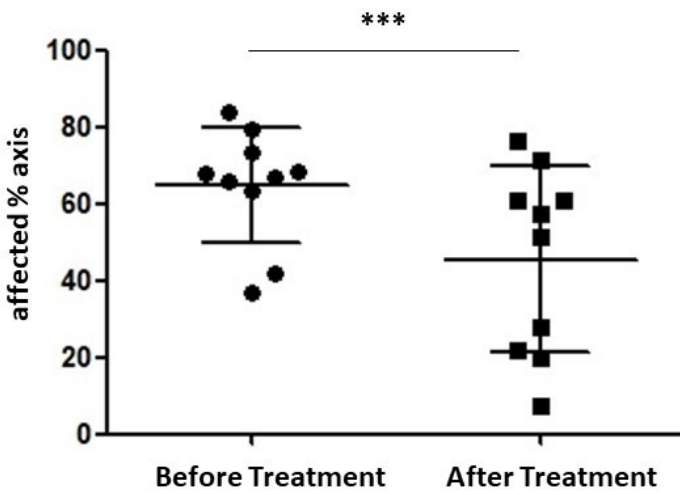
Figure 2. Same patient before and after treatment ( A , B ). Clinical improvement is observed, with a reduction in the affected area of the longitudinal axis from 68.57% to 20.00%. Another patient before and after treatment ( C , D ), showing clinically meaningful changes with a reduction in the affected area of the longitudinal axis from 41.94% to 28%.